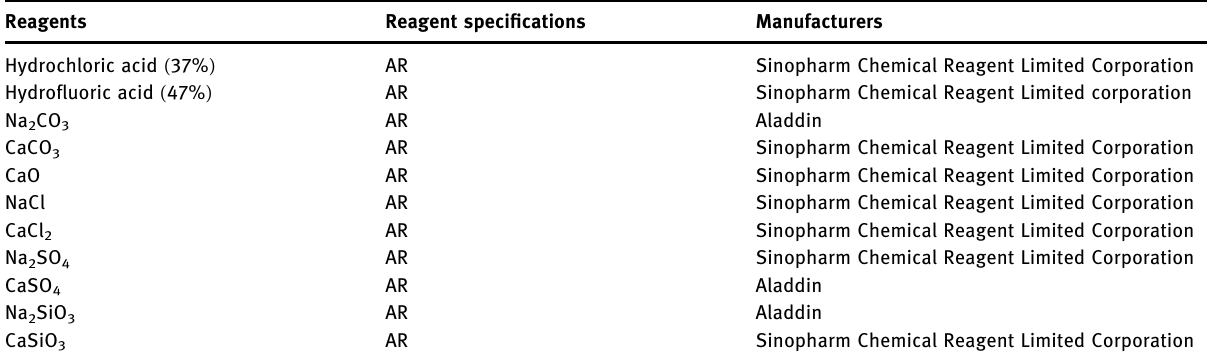
Table 2: Reagent speci fi cations and manufacturers